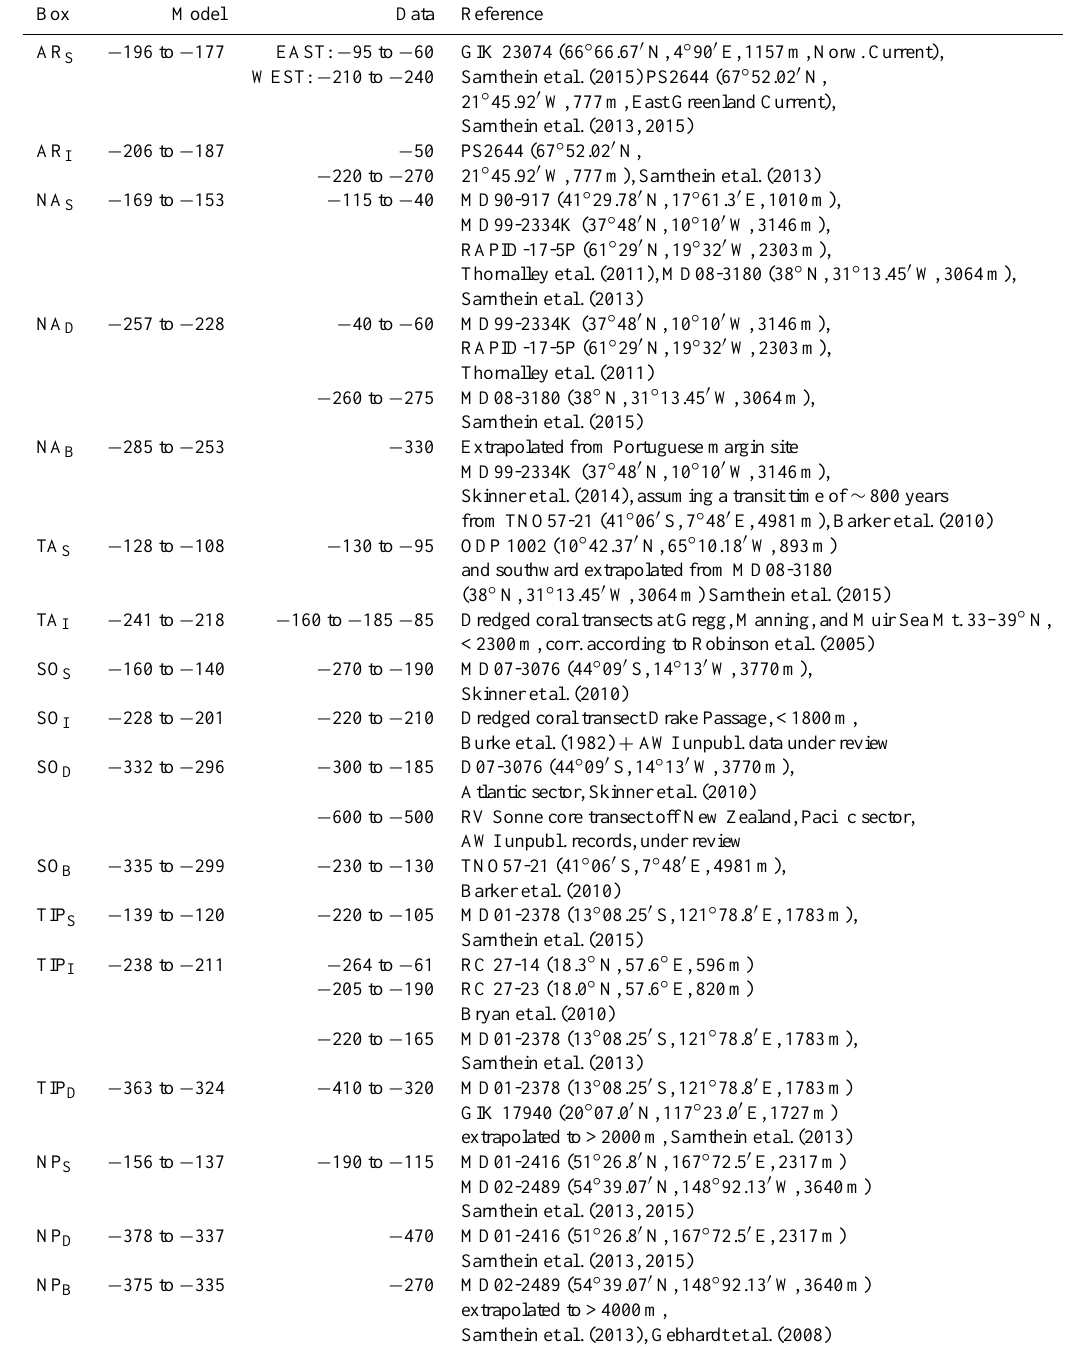
Table C3. (cid:49)(cid:49) 14 C-DIC for the LGM (19–23kyrBP) calculated in simulation STD and derived from radiocarbon measurements in